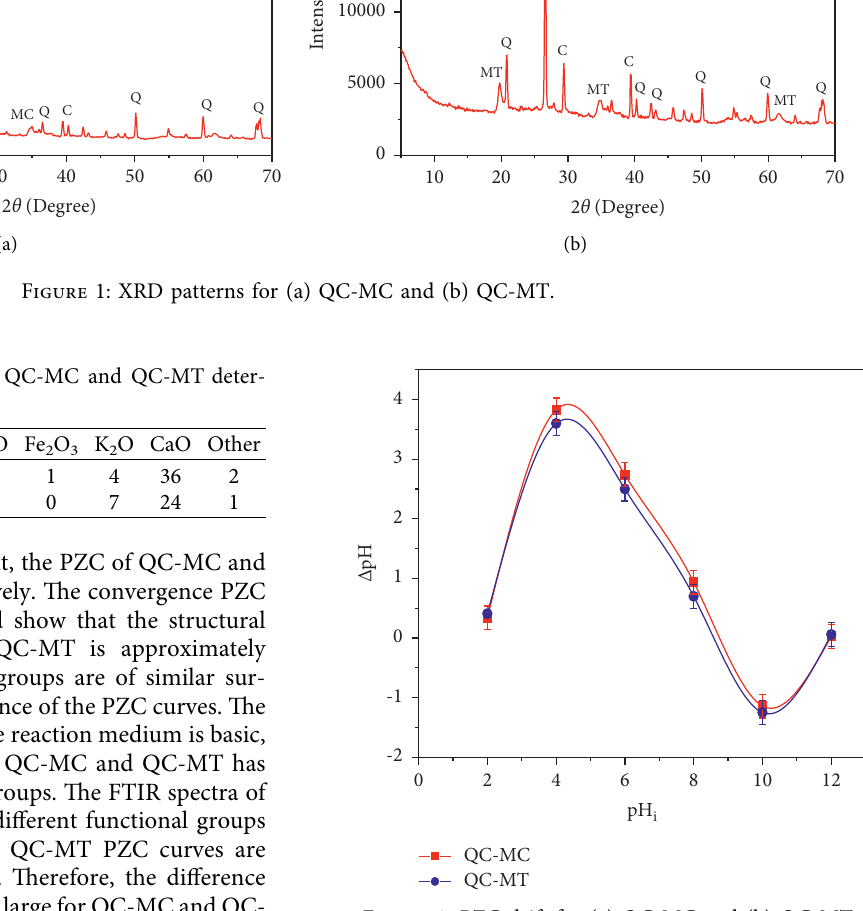
Figure 2: PZC drift for (a) QC-MC and (b)